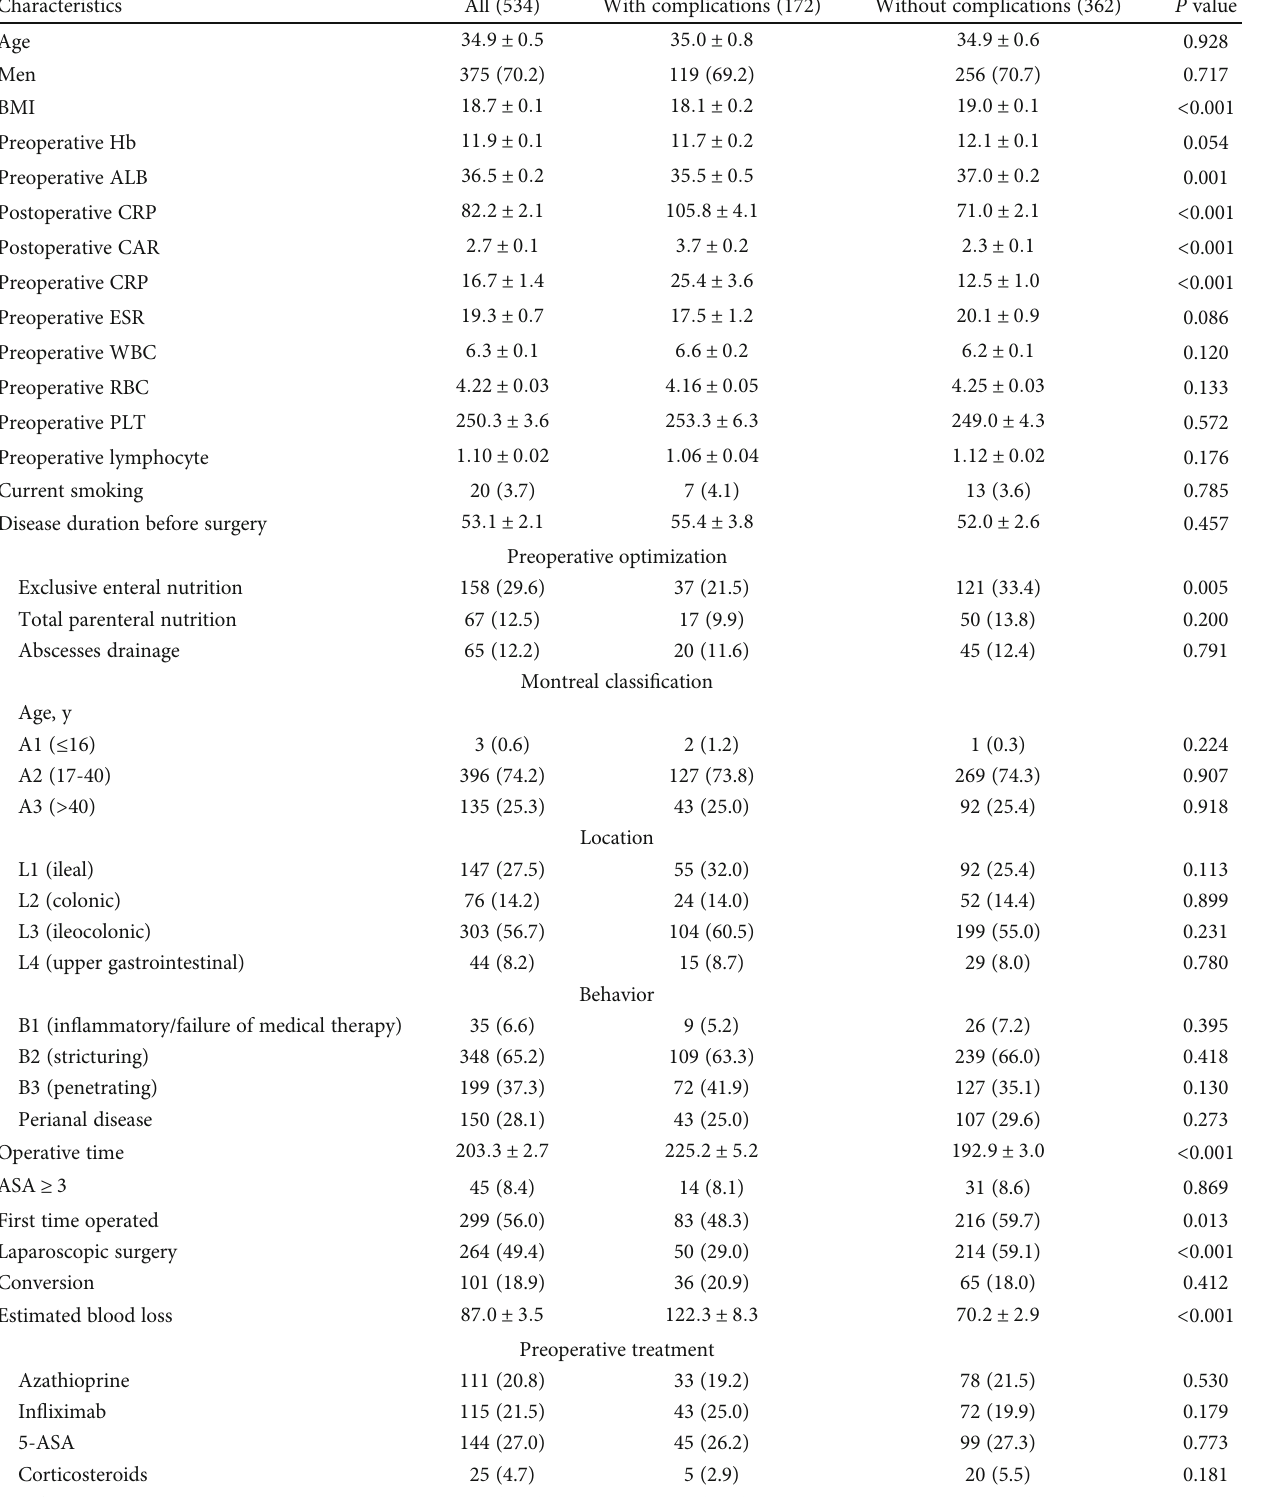
Table 1: Characteristic of participants and univariate analysis of risk factors associated with postoperative